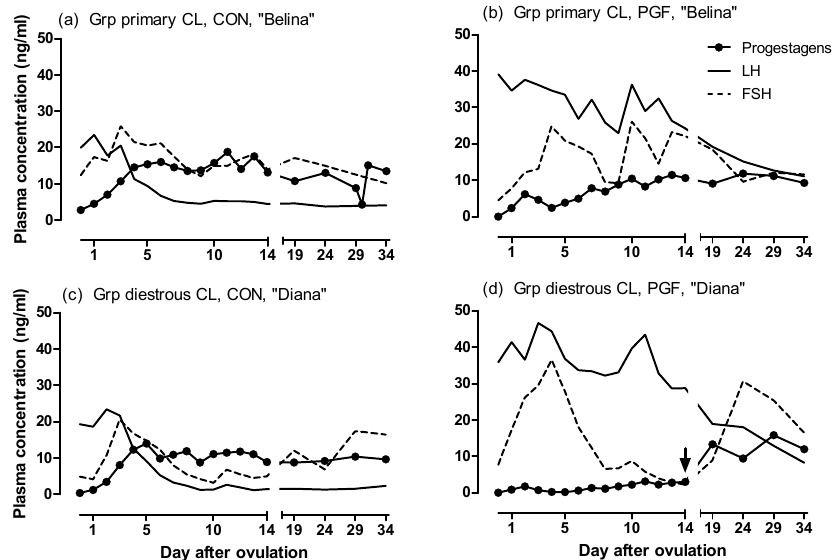
Figure 2. Concentrations of progestogens, LH and FSH in one representative mare from the group with primary CL in the ( a ) CON and ( b ) PGF pregnancy, and from the group with diestrous ovulation in the PGF pregnancy in her ( c ) CON and ( d ) PGF pregnancy. The day of the diestrous ovulation in ( d ) is indicated by an arrow. The total luteal tissue area was affected by group (Figure 3) with a larger total luteal tissue area in mares with a diestrous ovulation during the PGF-treatment pregnancy (group p = 0.001, treatment n.s., day × group p < 0.001, day × treatment p < 0.001). No significant correlations between luteal tissue area and progestogen concentrations were determined.